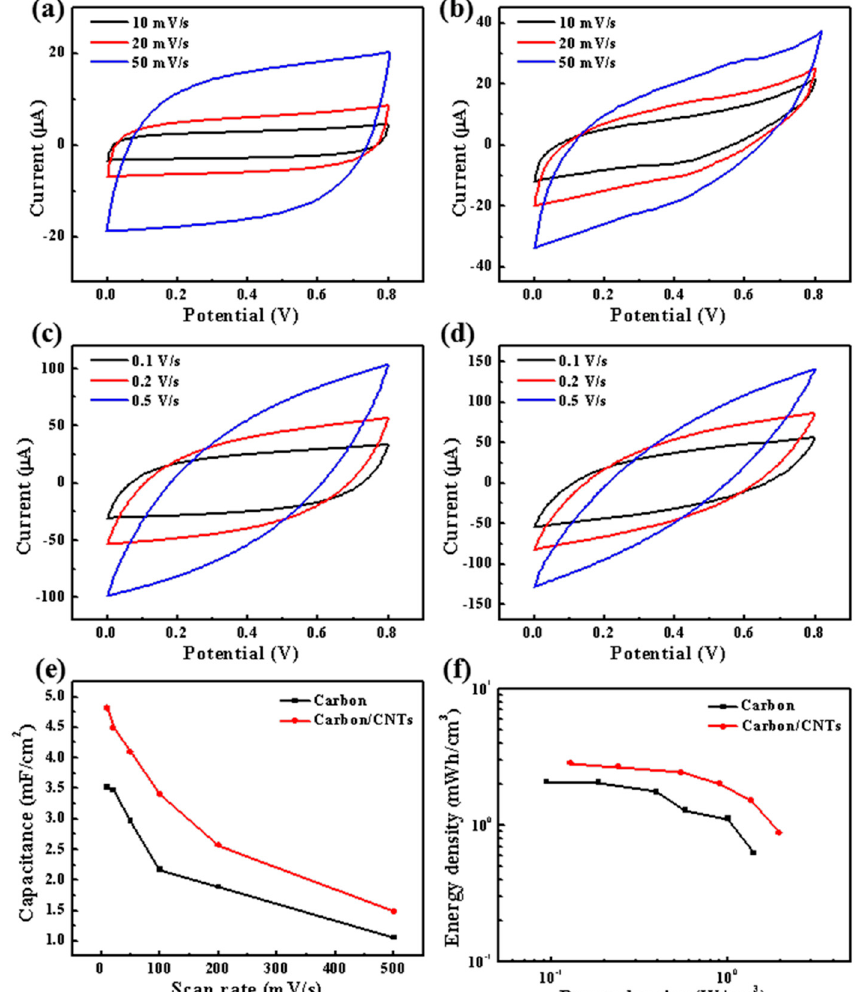
Figure 4. ( a ) CV curves of carbon-MSC at low scan rates. ( b ) CV curves of carbon/CNT-MSC at low scan rates. ( c ) CV curves of carbon-MSC at high scan rates. ( d ) CV curves of carbon/CNT-MSC at high scan rates. ( e ) Capacitance of carbon-MSC and carbon/CNT-MSC at different scan rates. ( f ) Energy density and power density of carbon-MSC and carbon/CNT-MSC, respectively.